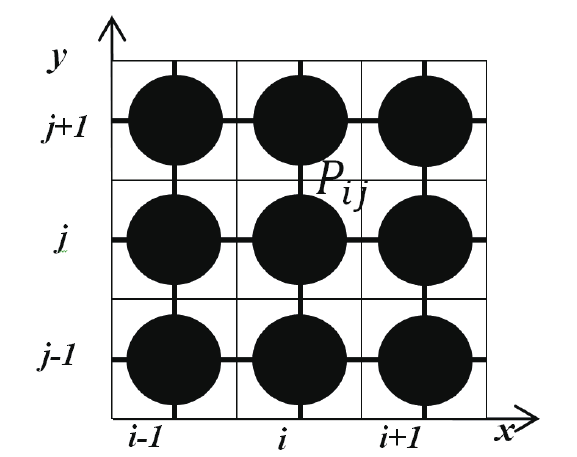
Figure 1. A 3 × 3 neighborhood of